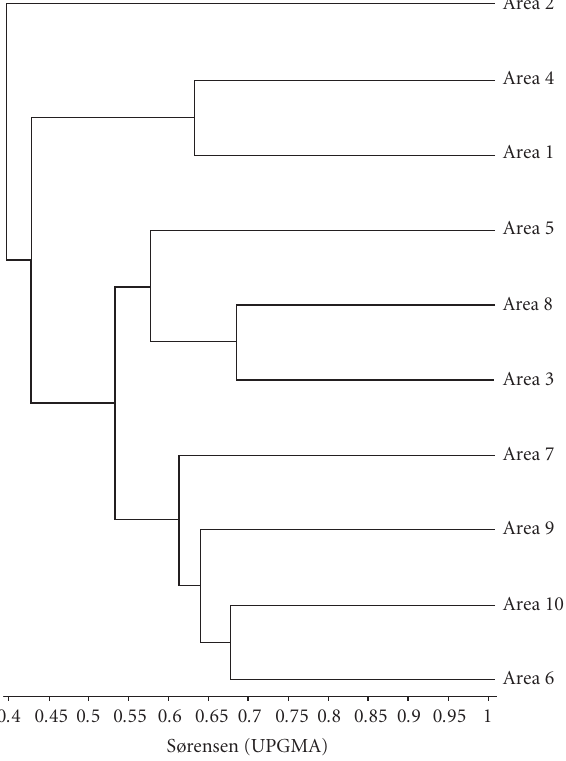
Figure 3: Dendrogram of similarity (Sørensen coe ffi cient) pro- duced by cluster analysis (UPGMA connection method) of tree species composition among the ten sites of seasonal semideciduous forest in southeastern